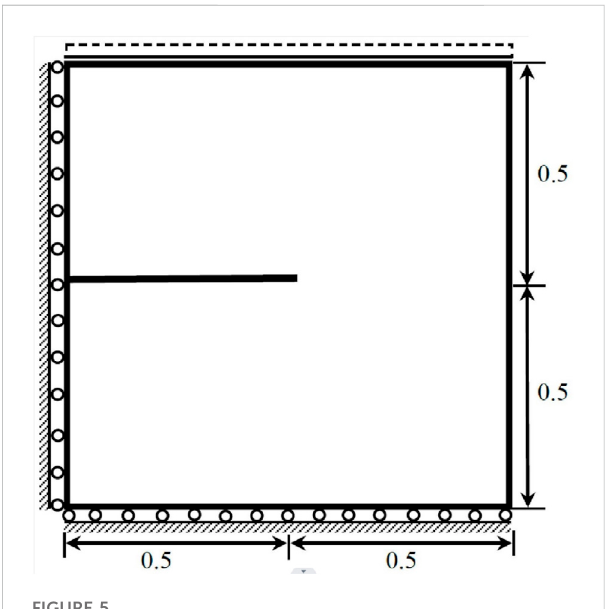
FIGURE 5 Geometrical setup and boundary conditions of the single-edge notched